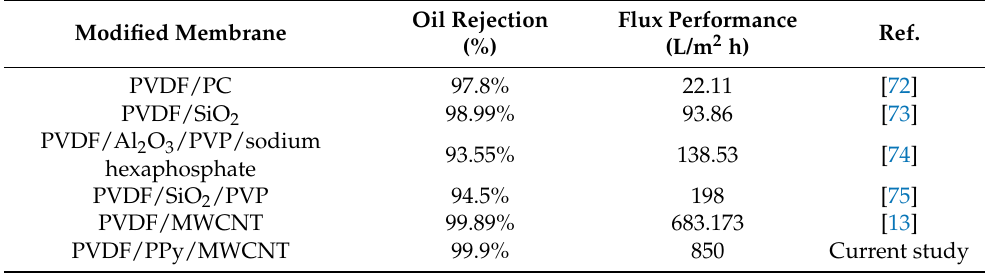
Table 7. Comparison of different types of modified PVDF membrane used for oil removal with the current